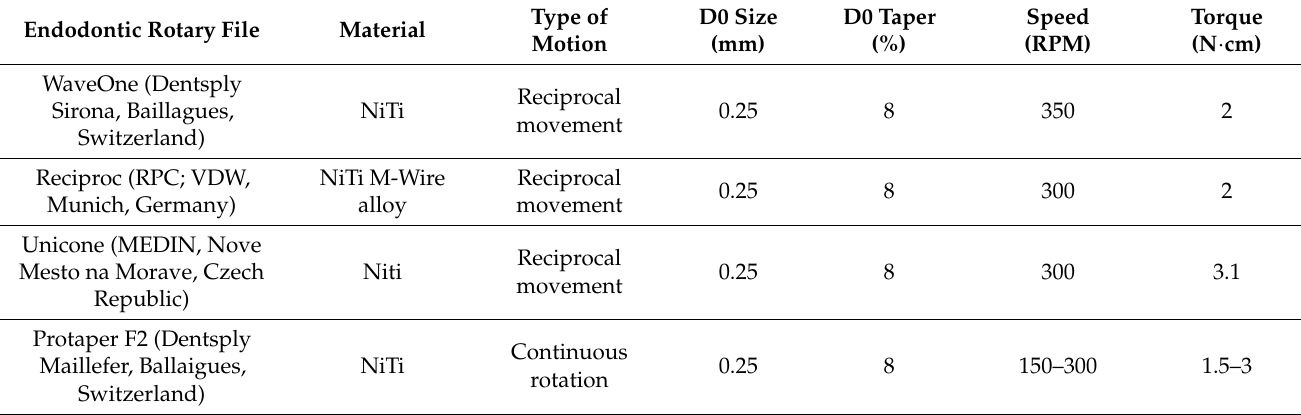
Table 1. Manufacturers of the four endodontic files.